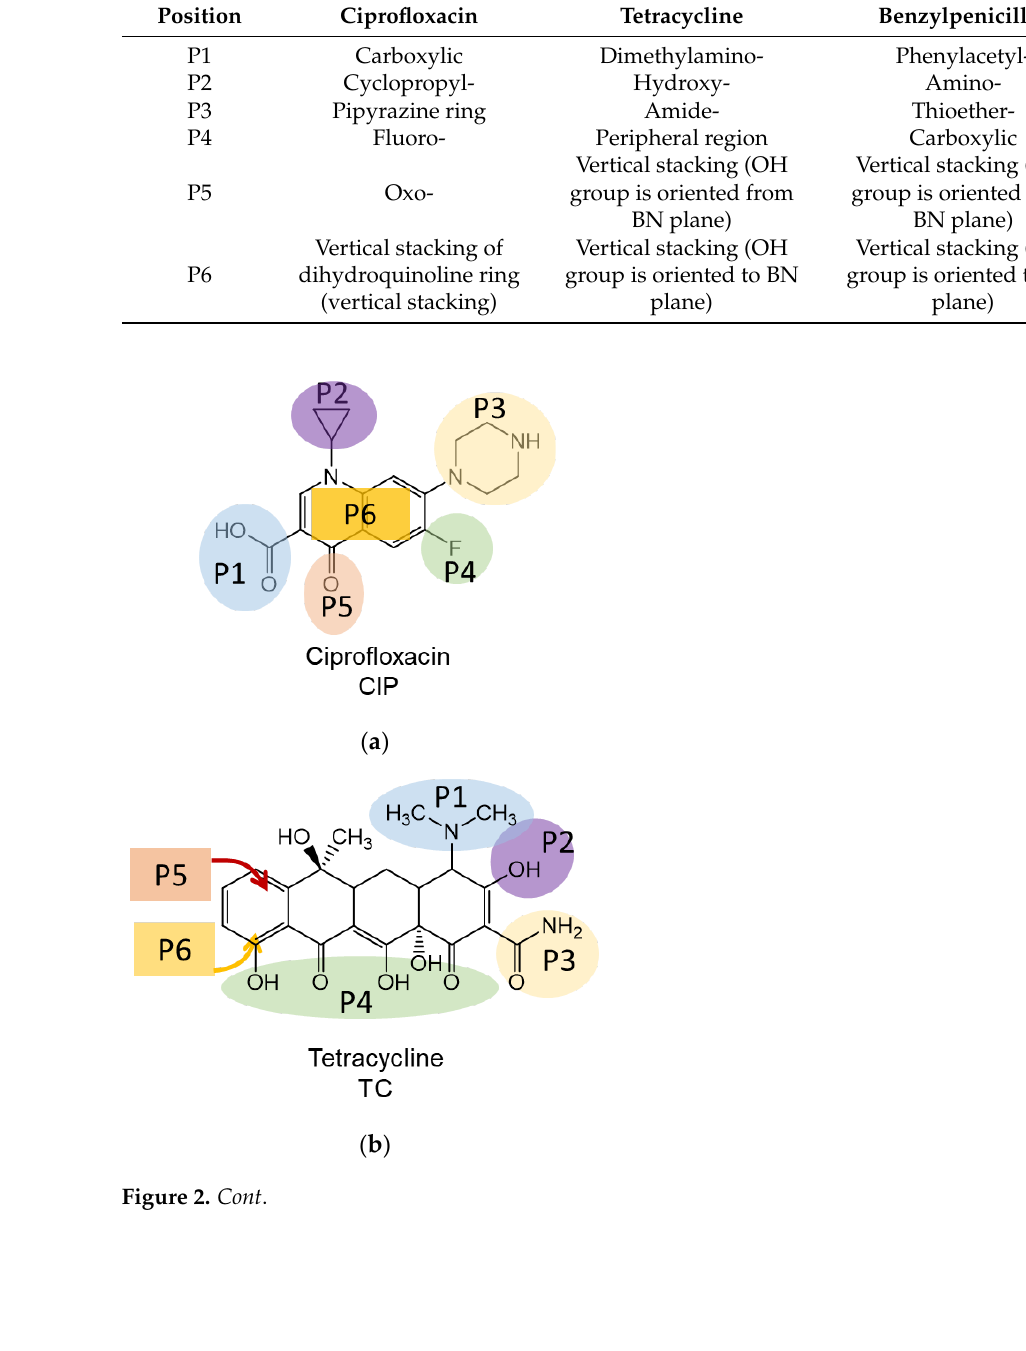
Table 1. Six antibiotic functional groups considered in theoretical calculations.